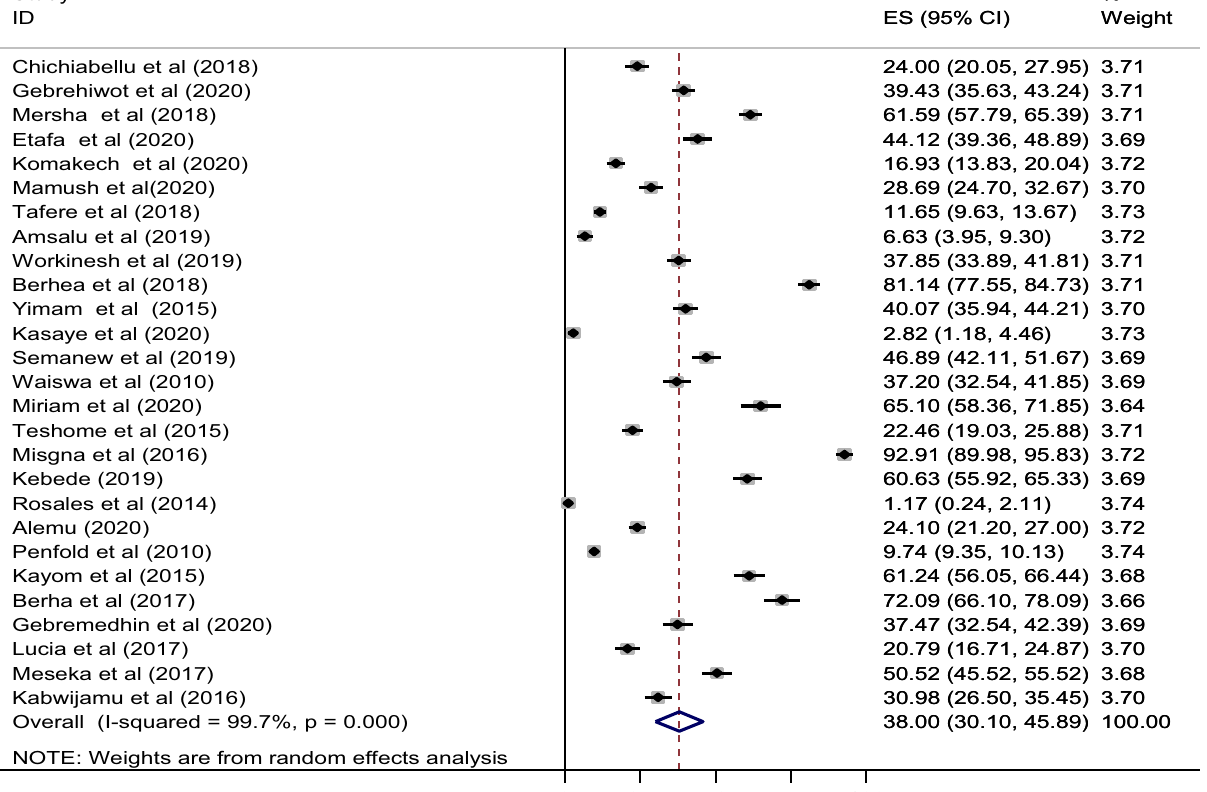
Figure 2. Forest plot of the pooled estimate of essential newborn care practice in east Africa.